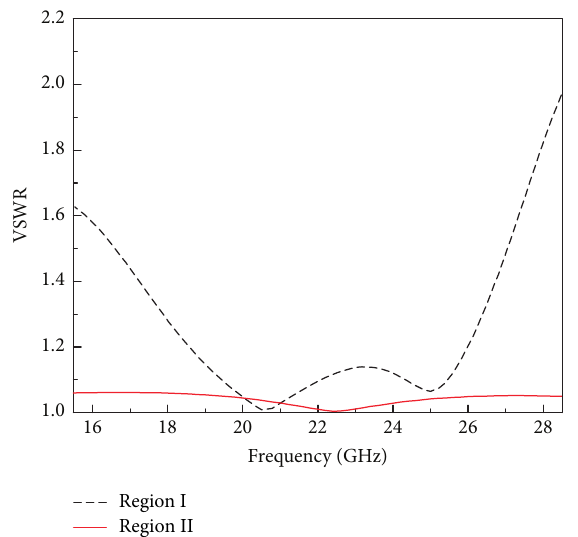
Figure 9: VSWR of feeding network in the simulation.